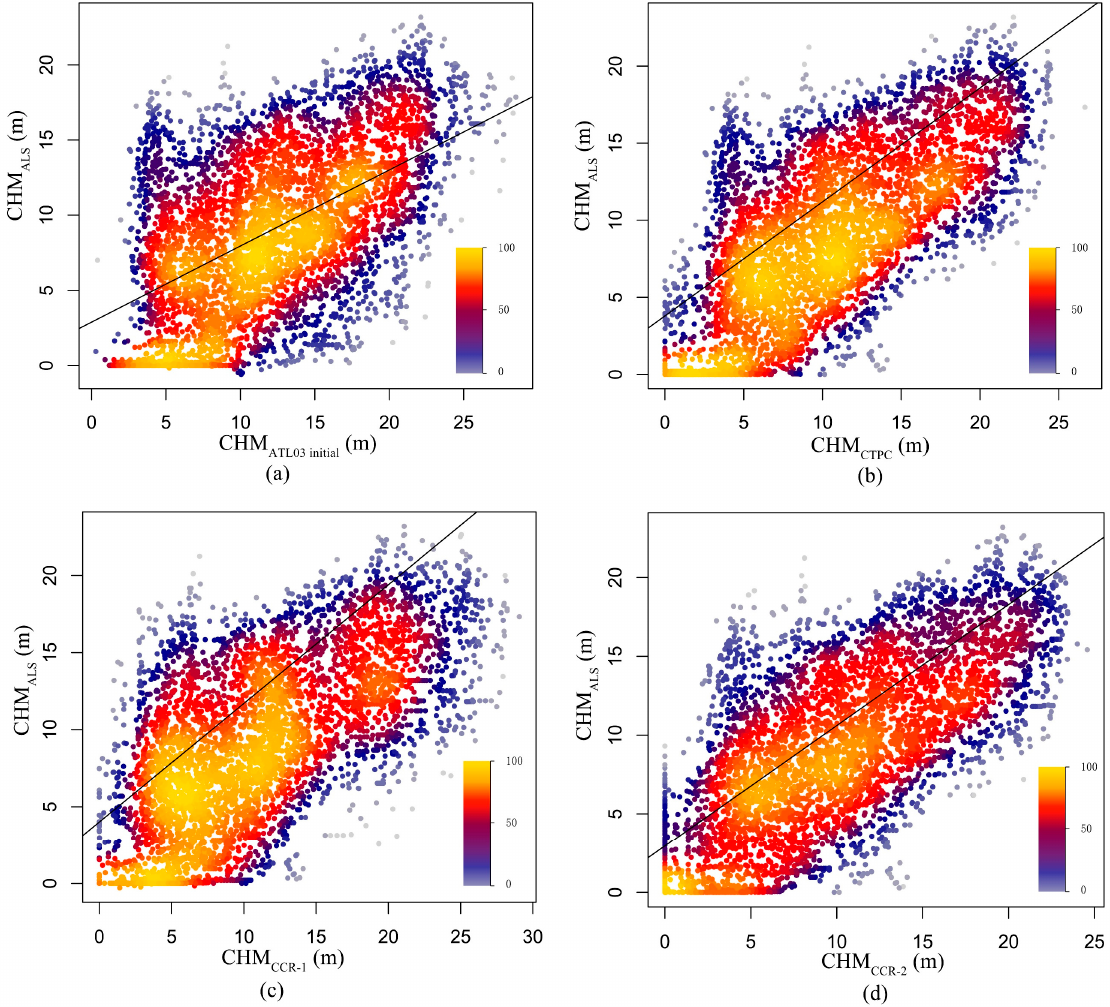
Figure 10. Scatter plot of tree heights retrieved by different methods and canopy height from CAF–LiCHy data: ( a ) uncorrected ICESat–2 tree height; ( b ) cross ‐ track photon corrected tree height, ( c , d ) tree height after cross ‐ track photon correction and TOC photon correction. The difference is that the D d value in ( c ) is derived from the 0.3 m image, and the D d value in ( d ) is obtained from the 0.2 m image.